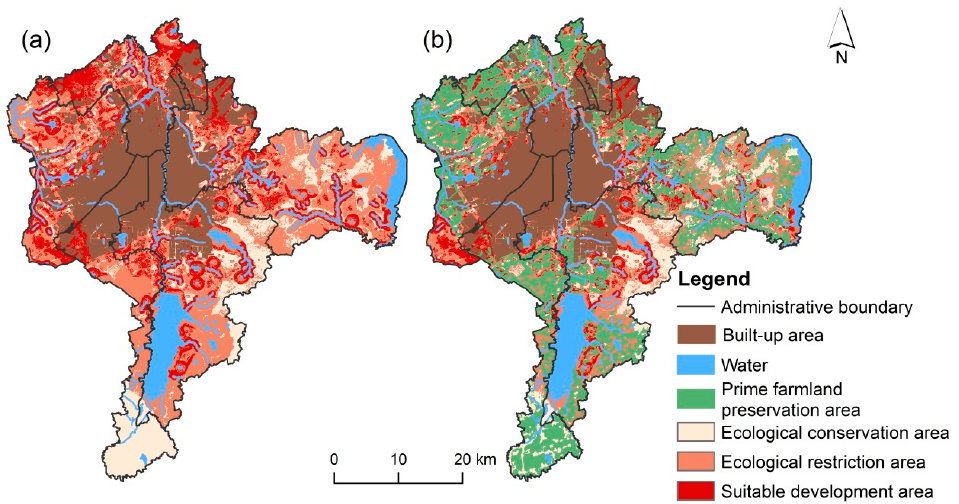
Figure 9. Urban expansion scenarios under the constraints of ( a ) the Ecological Security Pattern (ESP) and ( b ) the ESP and prime farmland preservation area.